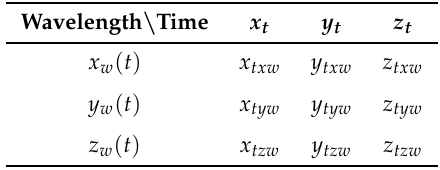
Table 3. List of all secondary chromatic